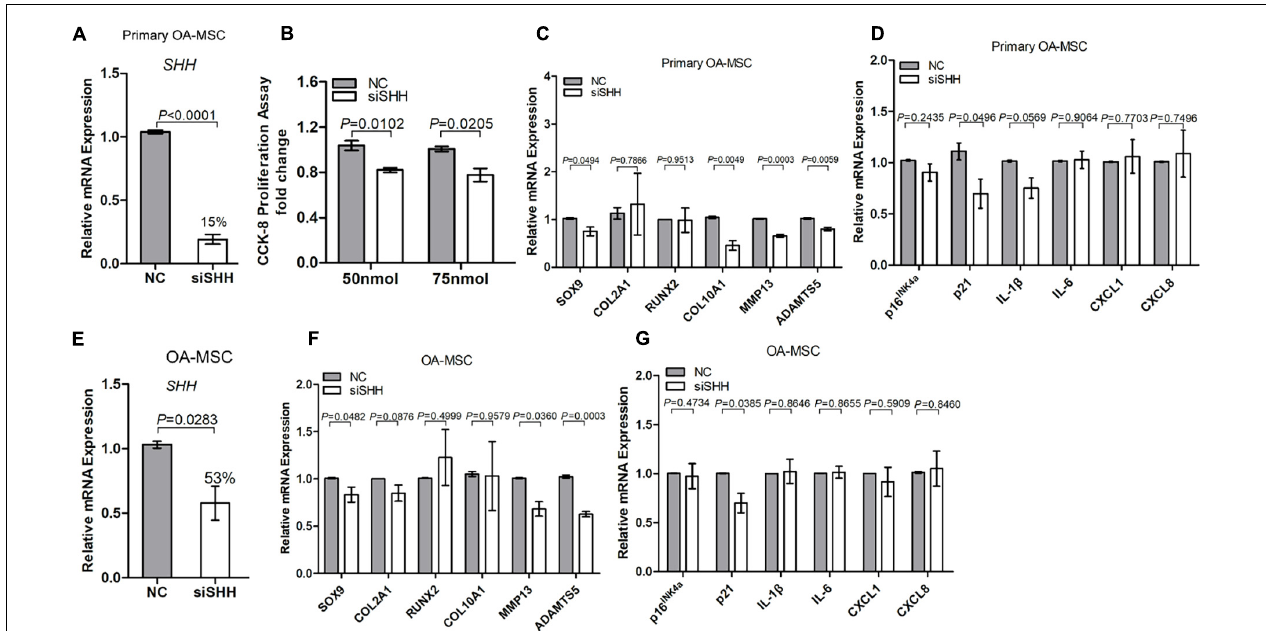
FIGURE 3 | Knocking down sonic Hedgehog ( SHH ) in osteoarthritis mesenchymal stromal cell (OA-MSC) inhibited proliferation and gene expression of markers of chondrogenesis, catabolism, and senescence. (A) Significant inhibition of SHH mRNA levels by SHH-siRNA (siSHH) transfection in primary OA-MSC. NC: normal control with mock transfection. p -value is indicated ( n = 3). (B) Significant inhibition of OA-MSC cell proliferation by siSHH in a dosage-dependent (50 and 75 nmol) manner. After transfection of siSHH for 48 h, the OA-MSC proliferation rate was quantified by CCK-8 proliferation assay. siSHH transfection significantly inhibited SOX9, MMP13, and ADAMTS5 (C) and p21 (D) in primary OA-MSC. (E) Significant inhibition of SHH mRNA levels by siSHH transfection in OA-MSC cell line. NC: normal control with mock transfection. p -value is indicated ( n = 3). siSHH transfection significantly inhibited SOX9 , MMP13 , and ADAMTS5 (F) and p21 (G) in OA-MSC cell line. All data are reported as mean ± S.E.M ( n = 3). p -value is